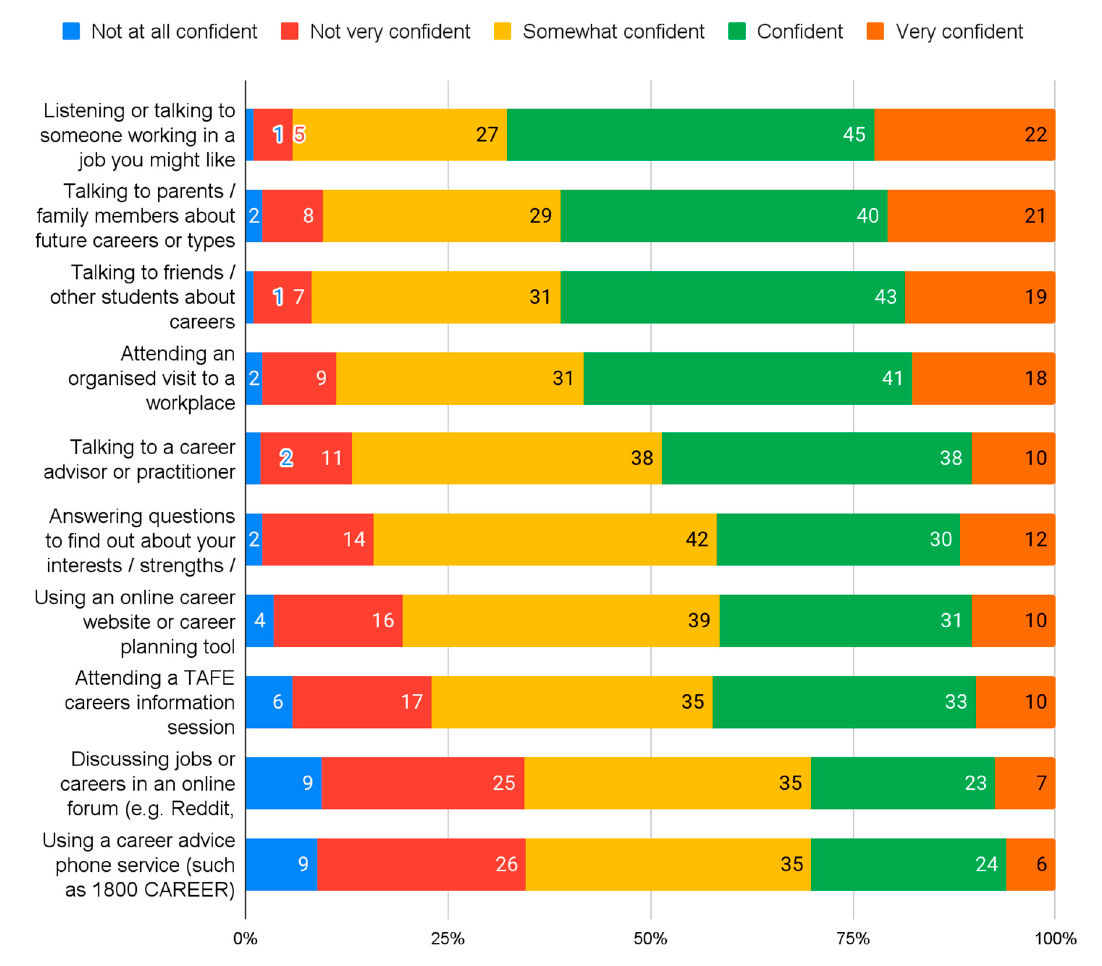
Figure 2. How confident are you that these activities would provide useful information? (Data source: Survey. n = 996 [excludes 112 (10%) respondents who reported in the preceding question that they were unlikely to undertake any of these activities in the next 12 months]).